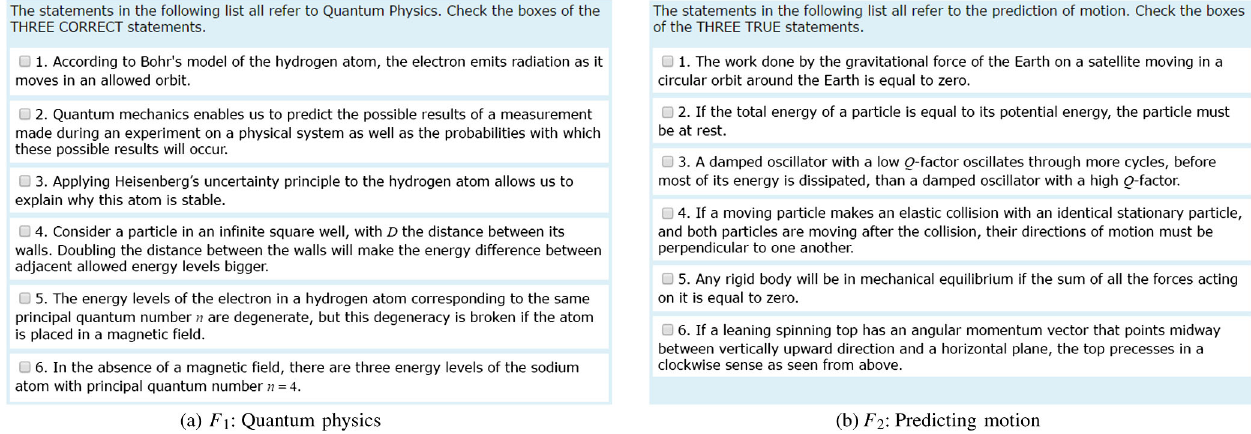
FIG. 2. iCMA questions displaying bias in favor of female